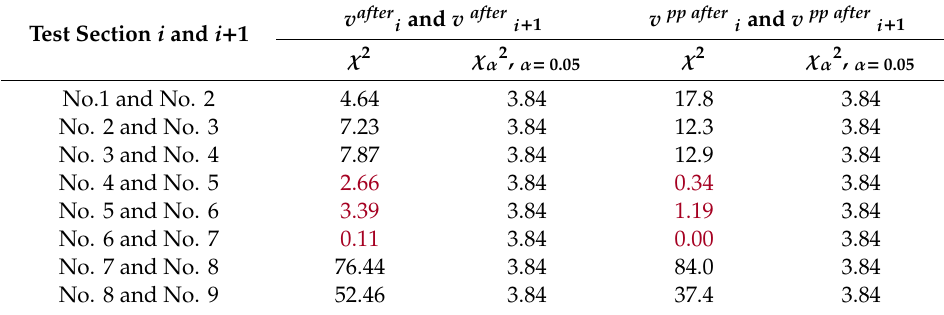
Designations colour in the table results of test of independence (free speed): H 0 : P { X = v after i , Y = v after i + 1 } = P { X = v after i }, P { Y = v after y in the table results of test of independence (vehicle flow speed): H 0 : P { X = v ppafter i , Y = v ppafter i + 1 } = P { X = v ppafter i }, P { Y = v ppafter y